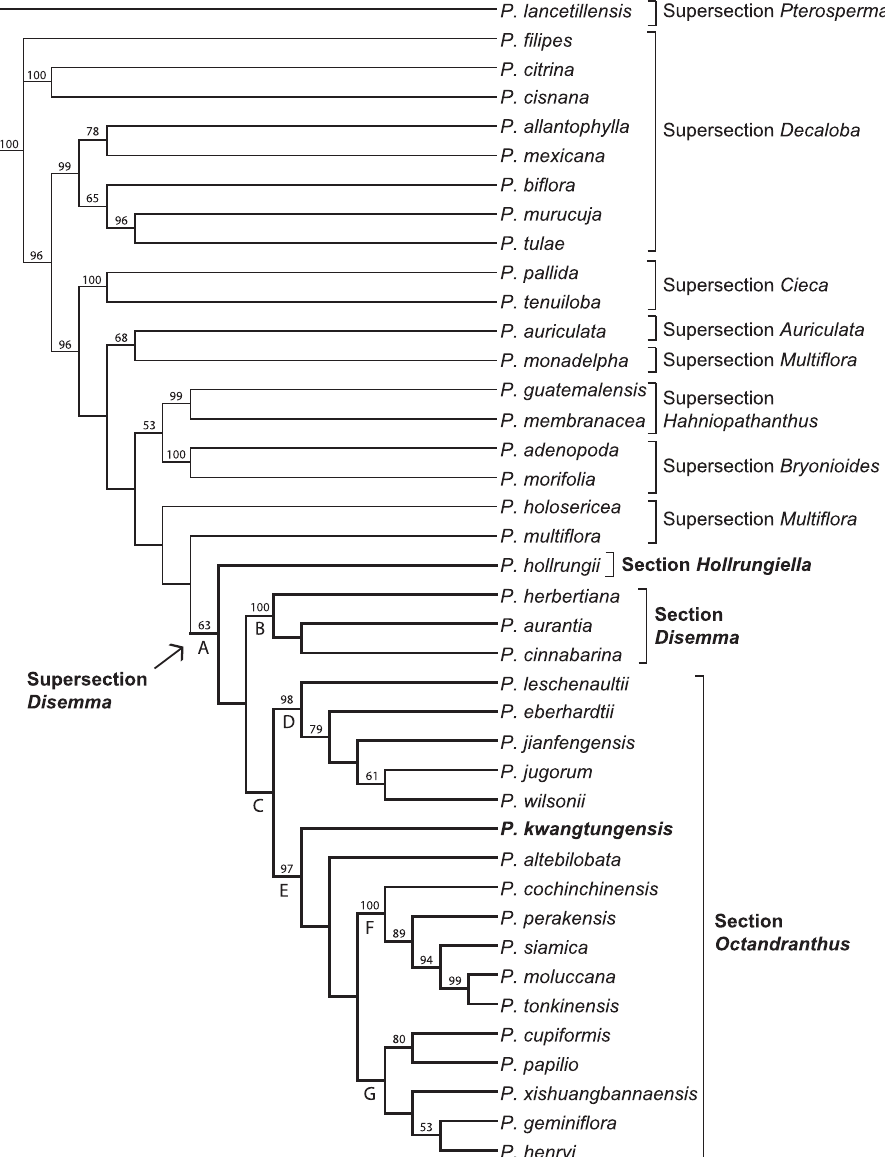
Figure 1. Strict consensus of two most parsimonious trees using ITS sequence data. Jackknife support above 50% listed above